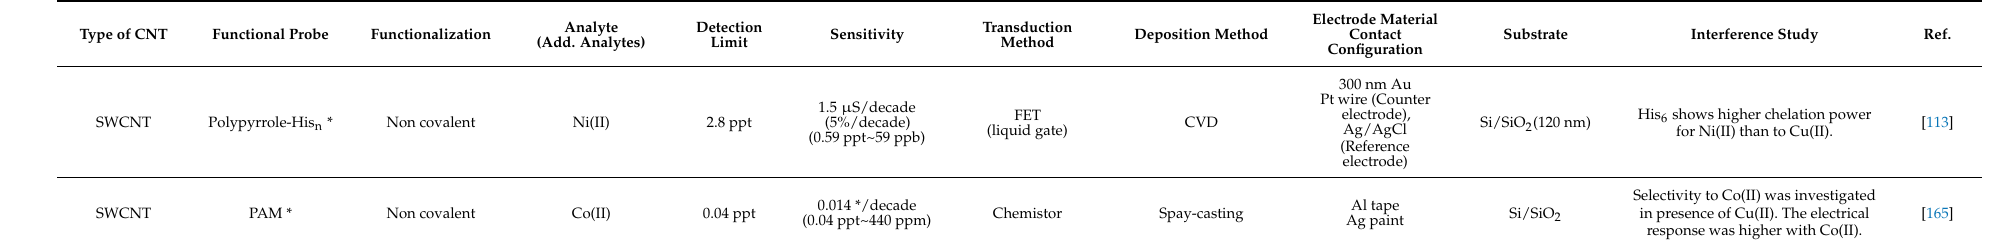
Table 9. CNT-based sensors for detecting Ni(II) and Co(II) ions in water.